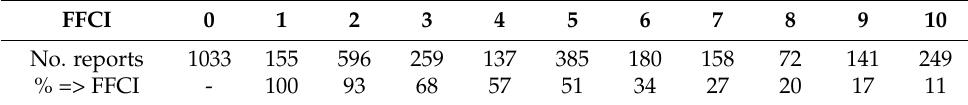
Table 5. FFCI distribution historical flood events in Ecuador.